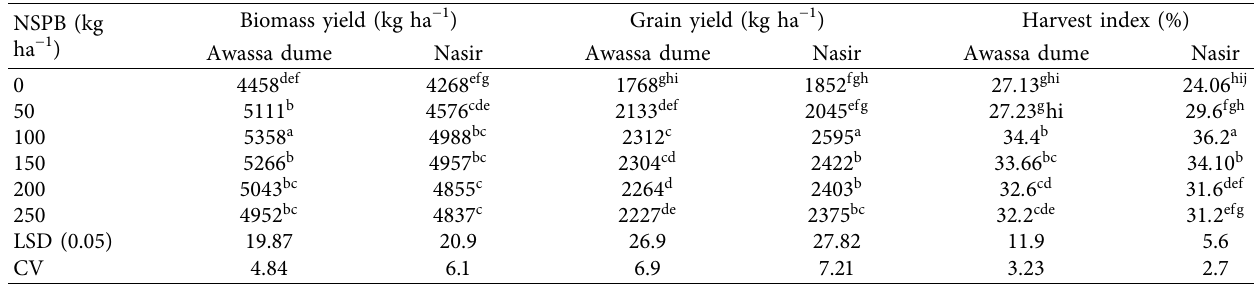
Figure 4: (a–d) Yield relation with uptakes of awassa dume common bean variety. Table 3: Interaction efects of varieties and blended NPSB fertilizer rates on biomass yield and grain yield of common bean at Meskan in 2020 cropping